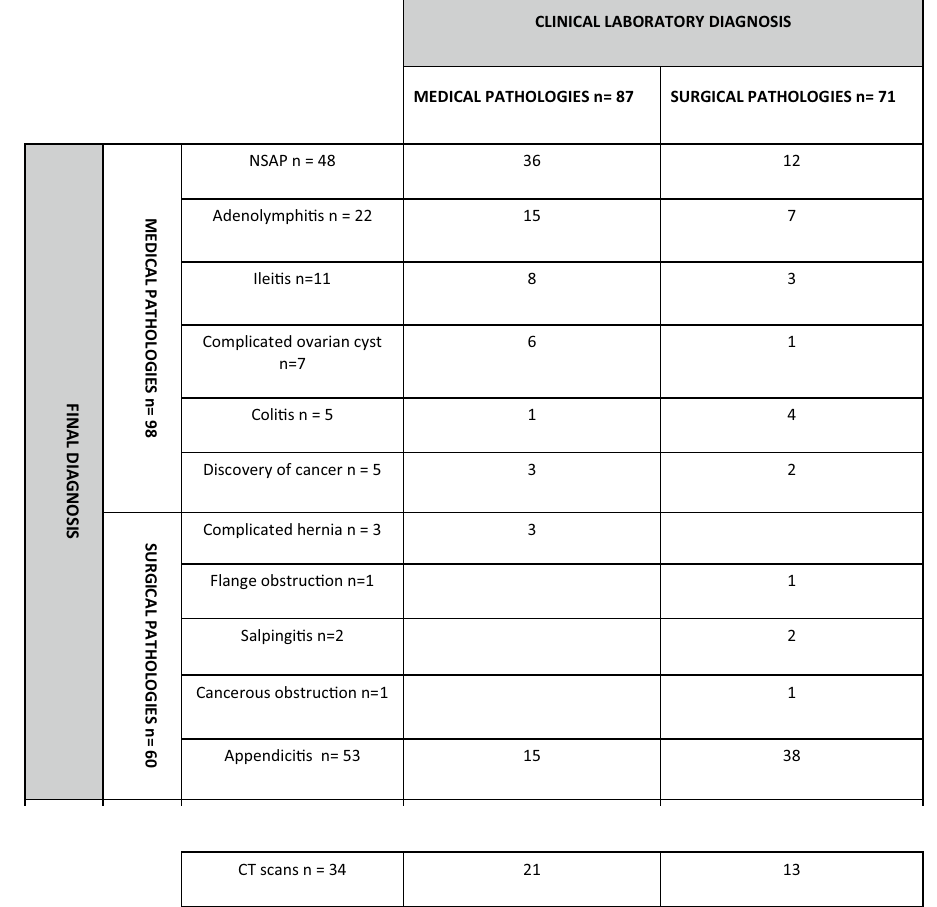
Table 2 Comparison of the clinical-laboratory diagnosis and the final diagnosis